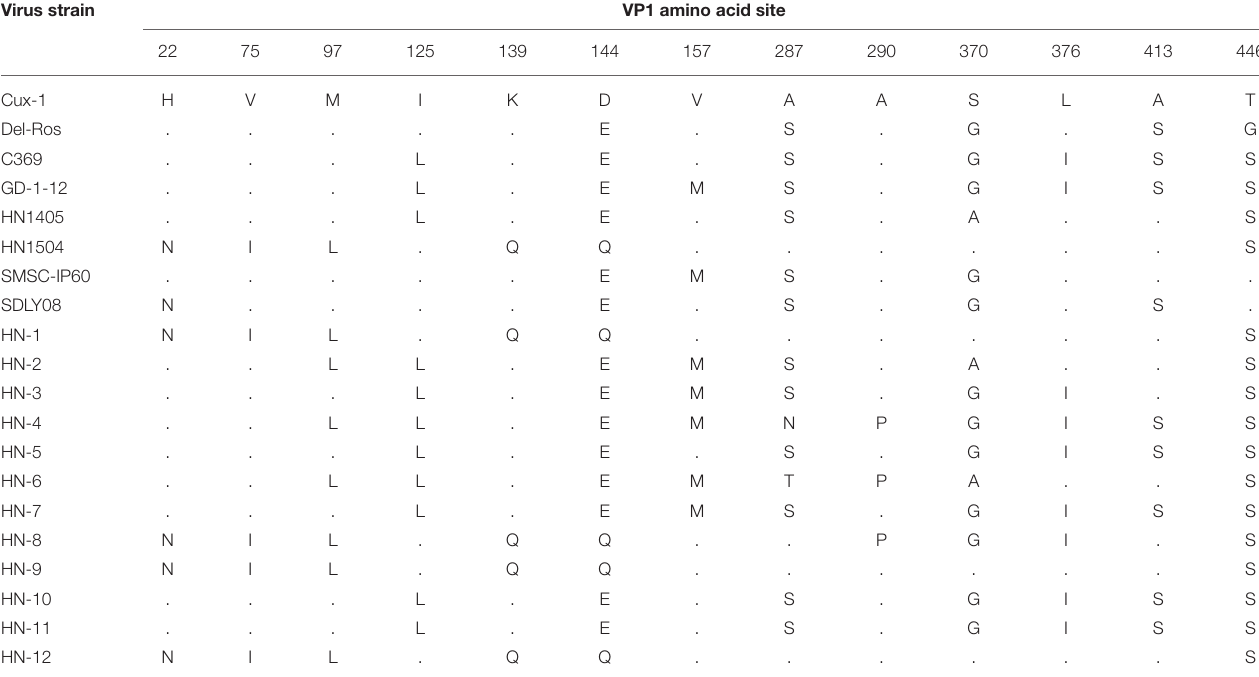
TABLE 2 | Main amino acid positions in the VP1 protein. Virus strain